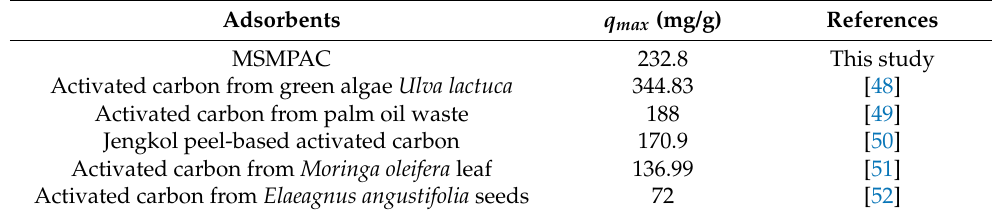
Table 8. Comparison of the adsorption capacity of MSMPAC towards MB dyes with different